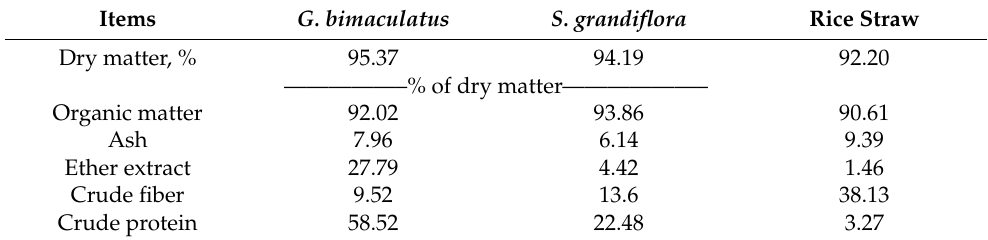
Table 1. Chemical composition of G. bimaculatus , S. grandiflora, and rice straw. Items